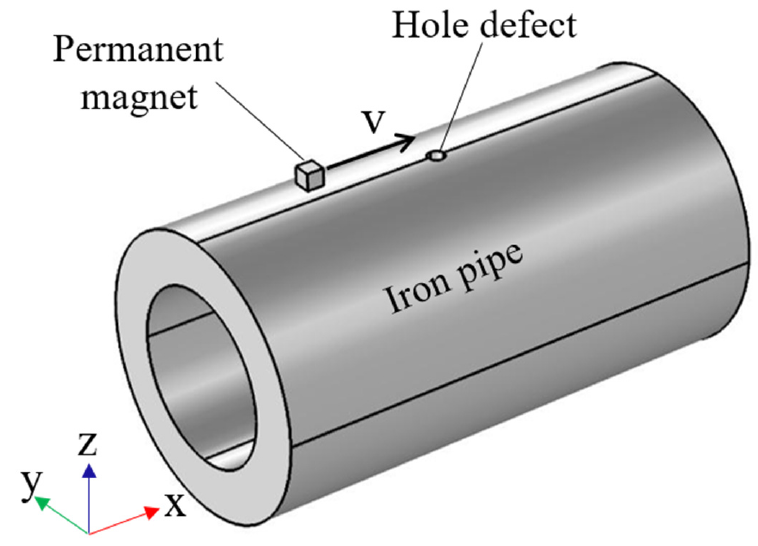
Figure 6. Sketches of the numerical model for the magnetostatic force . Table 1. Parameters in the numerical model.